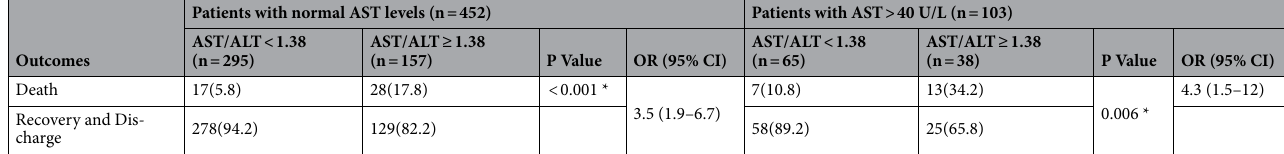
Table 5. Univariate analysis of the AST/ALT ratio on poor prognosis in the two groups of patients. Values are numbers (percentages) unless stated otherwise. Patients with clear survival data (recovery and death)